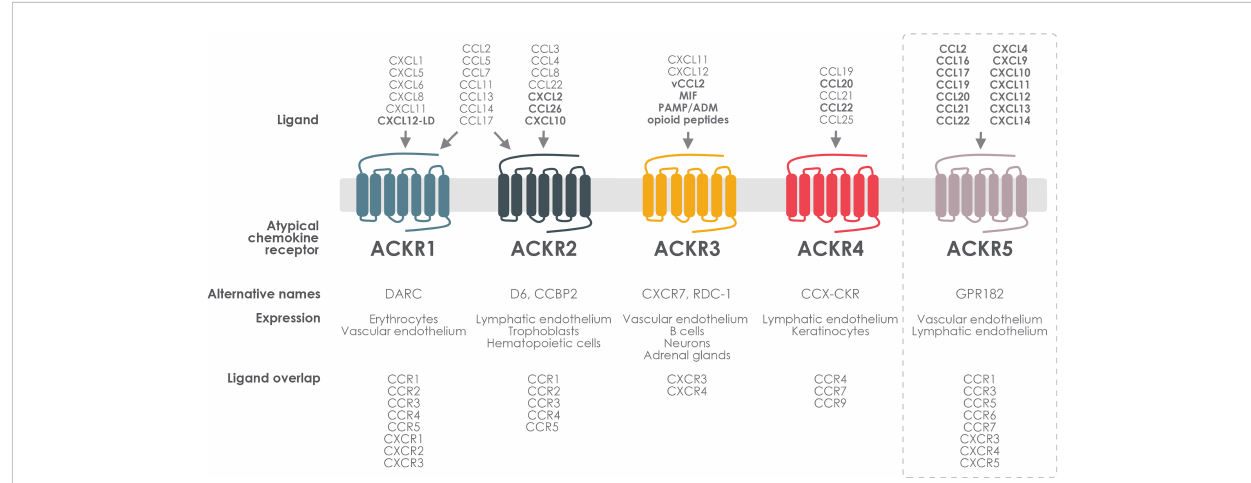
FIGURE 1 ACKR expression, ligand selectivity and crosstalk with classical chemokine receptors. Atypical chemokine receptors are expressed on different types of endothelial or immune cells. ACKR1 and ACKR2 bind a broad spectrum of in fl ammatory chemokines that they share with CXCR1 – 3 and CCR1 – 5. ACKR3 binds the homeostatic chemokine CXCL12, which it shares with CXCR4, and the in fl ammatory CXCL11, shared with CXCR3. ACKR3 also binds MIF and small non-chemokine peptides such as the proadrenomedullin-derived peptides, ADM and PAMP, as well as several opioid peptides. ACKR4 interacts with a limited number of mainly homeostatic chemokines that it shares with CCR4, CCR7 and CCR9. ACKR5 binds a wide range of both CC and CXC chemokines shared with CCR1, CCR3, CCR5 – 7 and CXCR3 – 5 and is still awaiting of fi cial IUPHAR recognition as an atypical chemokine receptor (dashed rectangle). Newly identi fi ed pairings are indicated in bold. CXCL12 – LD: CXCL12 locked